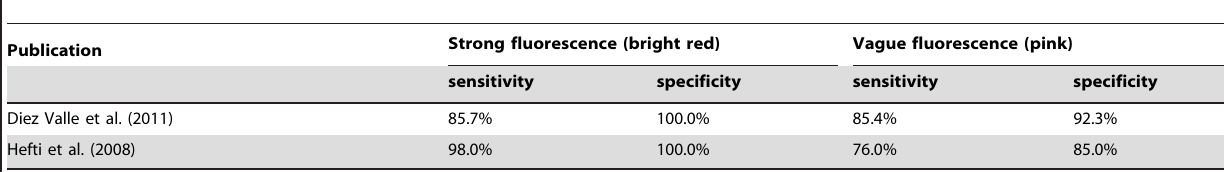
Table 5. Calculated sensitivity and specificity for strong fluorescence and vague fluorescence.